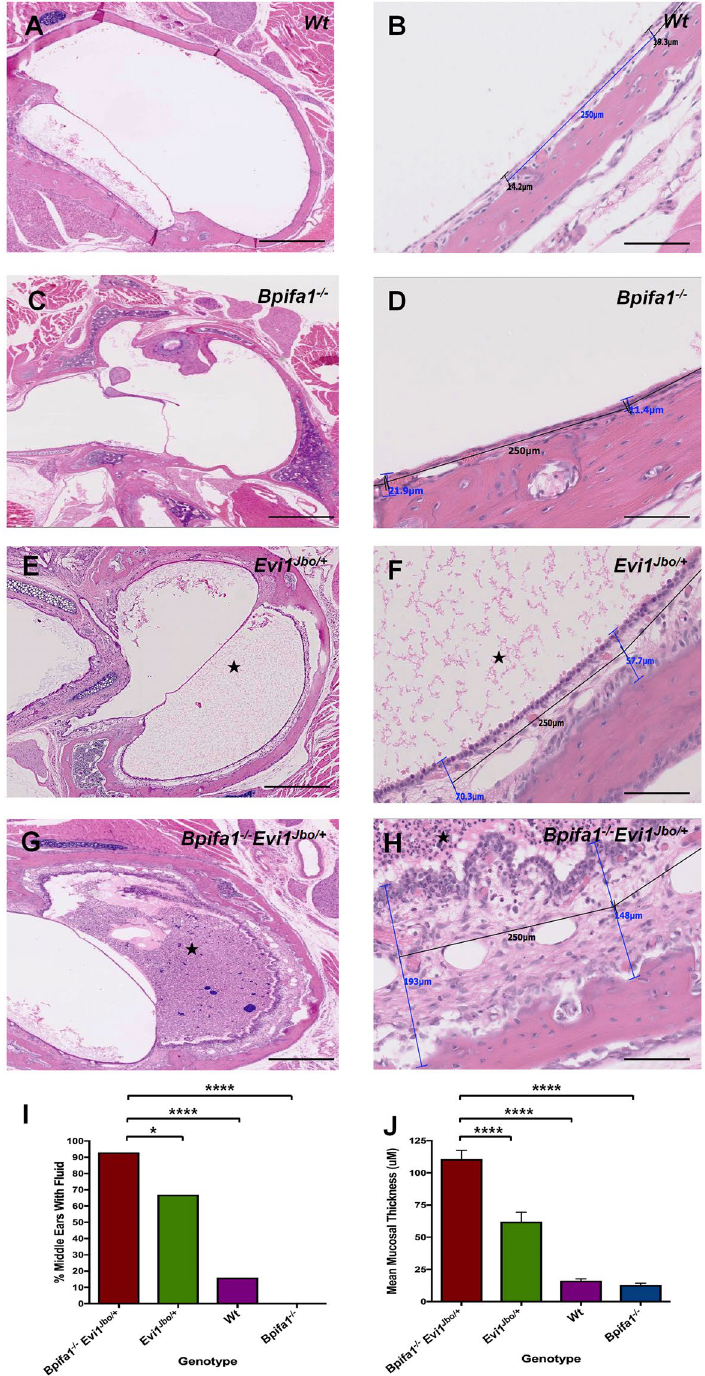
Figure 4. Exacerbation of otitis media severity in Bpifa1 + / − Evi1 Jbo/ + mice. Dorsal plane H&E sections from MEs of P28 WT (n = 28) ( A , B ) and Bpifa1 − / − (n = 12) ( C , D ) mice show no otitis media development. Representative H&E sections from ME of P28 Evi1 Jbo/ + (n = 34) ( E , F ) and Bpifa1 − / − Evi1 Jbo/ + (n = 32) ( G,H ) mice demonstrate presence of an OM phenotype characterised by mucosal thickening and the presence of inflammatory ear fluids (marked by star). Mucosa of Bpifa1 − / − Evi1 Jbo/ + ( G , H ) appears thicker than Evi1 Jbo/ + mice ( E , F ). Scale bar 500 μ m for low magnification images and 100 μ m for high magnification images. High power images show overlays used to quantitate epithelial thickness. The percentage of MEs with grossly evident fluids (Fishers exact test) ( I ) and the mean mucosal thickness (One-way ANOVA with Tukeys post hoc test) ( J ) for Bpifa1 − / − Evi1 Jbo/ + was significantly higher compared to Evi1 Jbo/ + , WT and Bpifa1 − / − mice; * p < 0.05; ** p < 0.01; **** p <